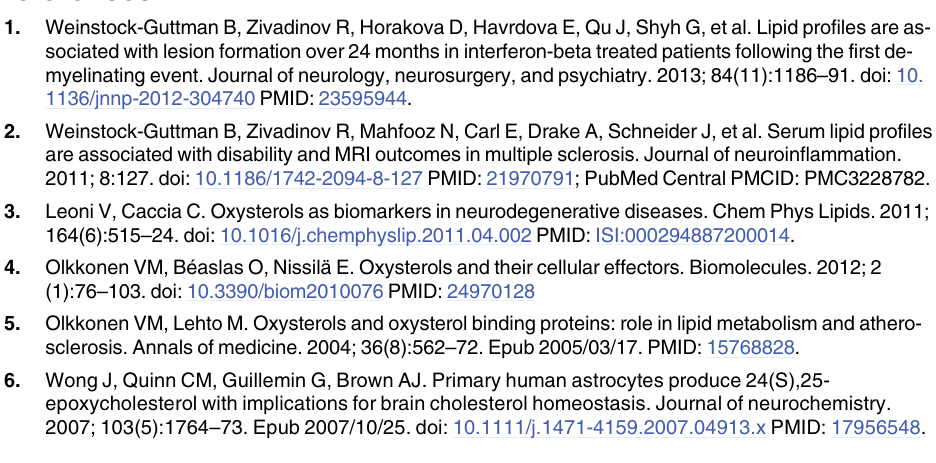
S1 Fig. Detailed total ion chromatogram (TIC) and each corresponding selected ion moni- toring (SIM) time segment (1 – 4) for a mixture of 20 analyte standards including internal standards. Peaks are labeled with the acronym as listed in Table 1. S2 Fig. Detailed total ion chromatogram (TIC) and each corresponding selected ion moni- toring (SIM) time segment (1 – 4) for a representative plasma sample including internal standards. Peaks are labeled with the acronym as listed in Table 1. Peaks labeled A1 and A2 represent artifact peaks observed following sample processing. S1 Table. Chromatographic peak parameters and limits of detection for analytes. S2 Table. Intra- day accuracy (range of % deviation from nominal value) of the calibration standards, regression coefficients values, slopes of the calibration curves and y- intercept values for 25-hydroxy-vitamin D3 (VitD3), five oxysterol standards and cholesterol on three different days. S3 Table. Means, standard deviations and CV% for plasma QC sample stored at -80°C, and commercial, lyophilized, quality control materials. Plasma QC represents 88 replicates across 44 analytical batches and 17 months of analysis. DC-TROL I and II represent analyses across six separate lyophilized vials reconstituted from a single production lot